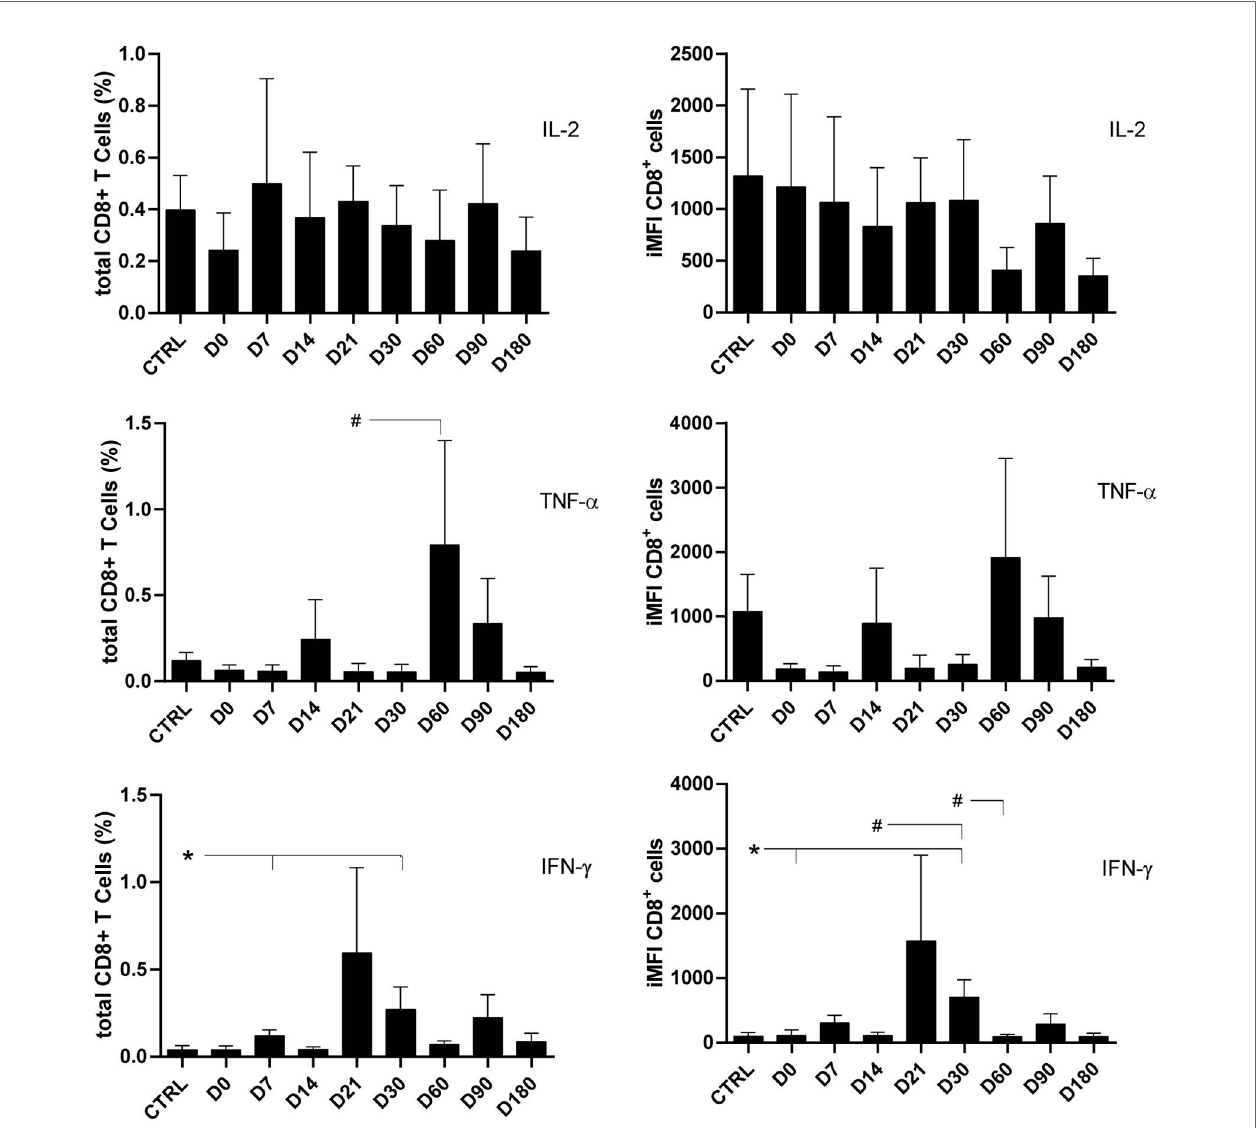
FIGURE 3 | Total frequencies and integrated mean fl uorescence intensity (iMFI) of cytokine-producing CD8 + T cells. The total frequencies and iMFI of each cytokine- expressing phenotype were determined in peripheral blood mononuclear cells (PBMCs) from healthy controls and patients before (D0) and during their treatment follow-up, after subtracting the background values corresponding to cells incubated without the soluble Leishmania antigen (SLA). Results in the panel are expressed as means+SE. Asterisks and horizontal lines indicate signi fi cant differences between times of treatments and healthy control records as disclosed by the Mann – Whitney method. Hashtags show signi fi cant differences between any time of treatment as determined by the Wilcoxon matched-pairs rank statistical